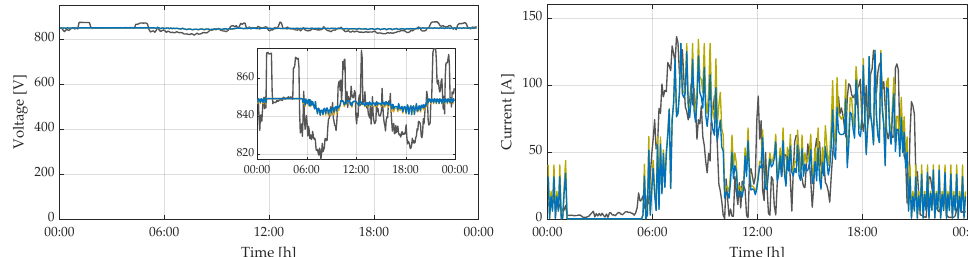
Figure 20. Voltage ( left ) and current ( right ) in TS T-T in an average window of 5 min. Measurements (black), simulation results with gross weight (yellow), and results of the weight-based simulation (blue). The plots cover a 24-h simulation scenario.